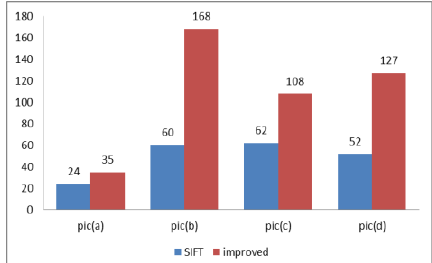
Figure 4(a)number of result points by SIFT algorithm and improved algorithm. Blue bar for SIFT algorithm and red bar for zero-crossing algorithm. The x-axis showed different group of test images and the y-axis stands for the number of result features.